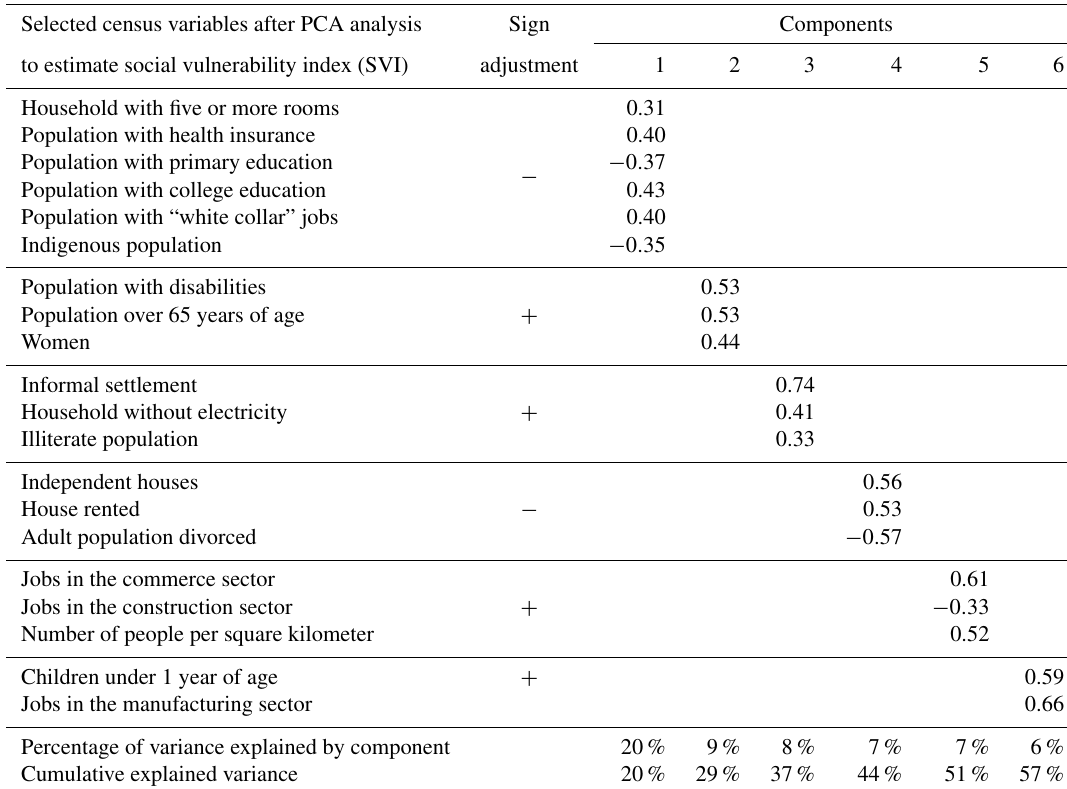
Table 3. Summary of PCA results. Selected census variables after PCA